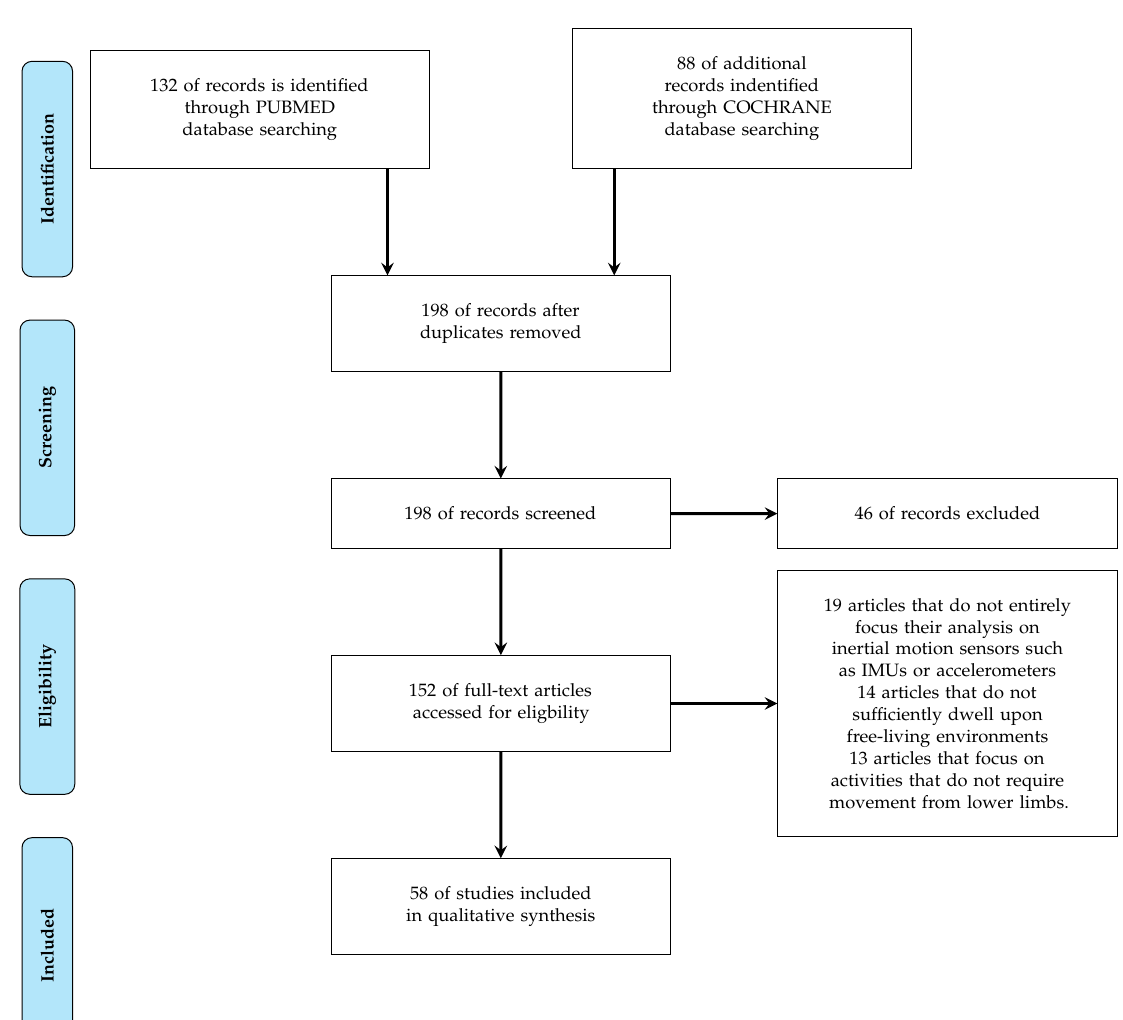
Figure 1. PRISMA flow chart illustrating the selection process resulting in a list of 58